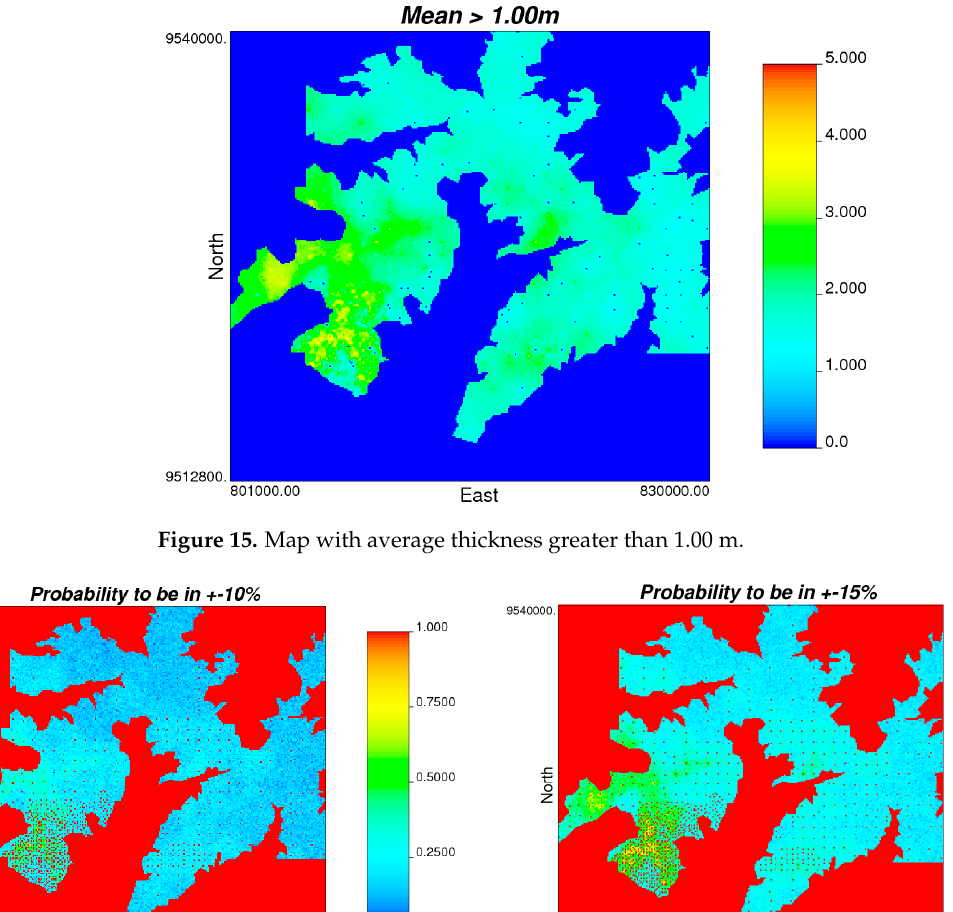
Figure 15. Map with average thickness greater than 1.00 m.